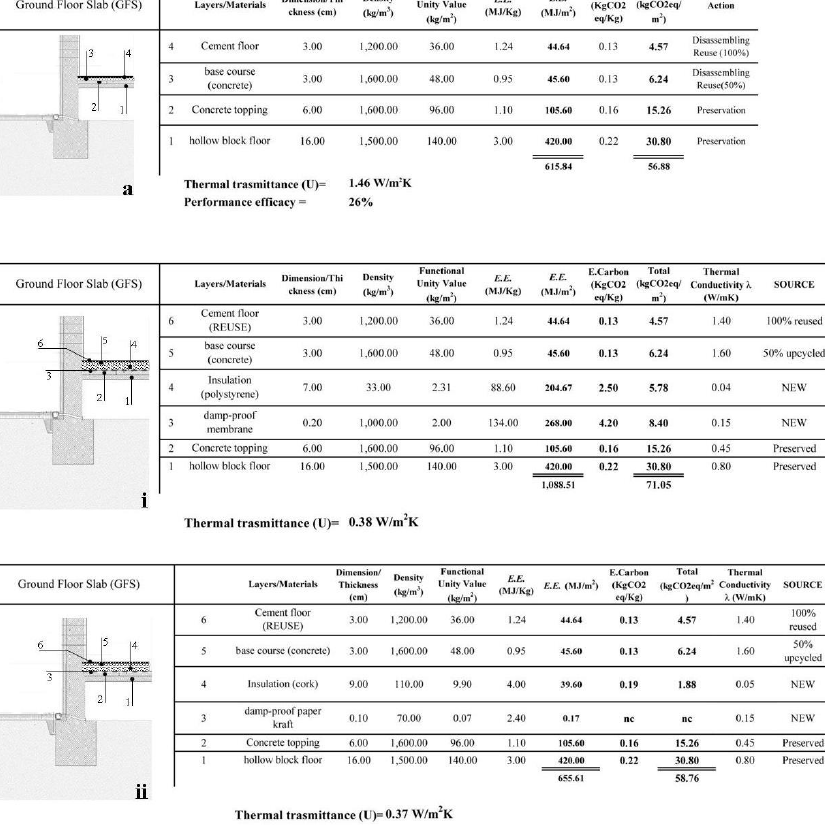
Figure 10. Ground floor slab: current status ( a ); design alternative ( i ); design alternative ( ii ).